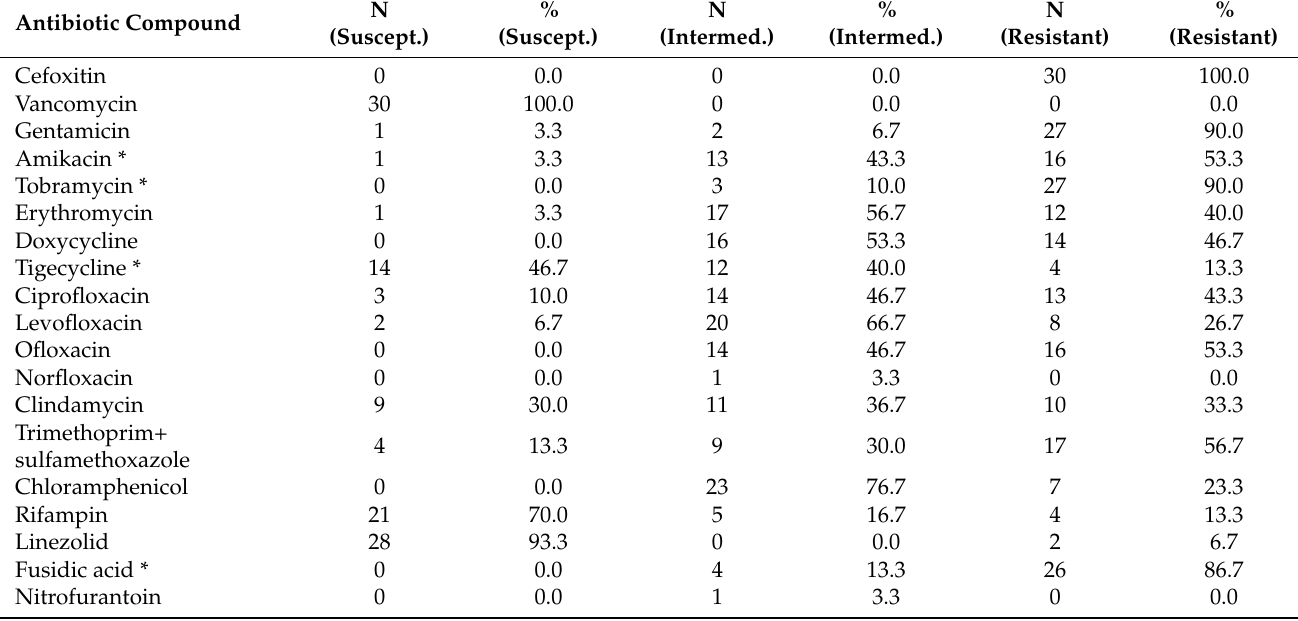
Table 2. Susceptibility of MRSA isolates to antibiotics using the Kirby–Bauer disk diffusion method according to CLSI guidelines or if no interpretive criteria are recommended by the CLSI, according